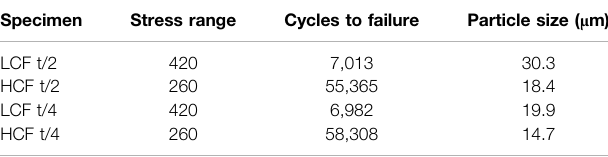
TABLE 5 | Fatigue test results and particle size of crack initiating